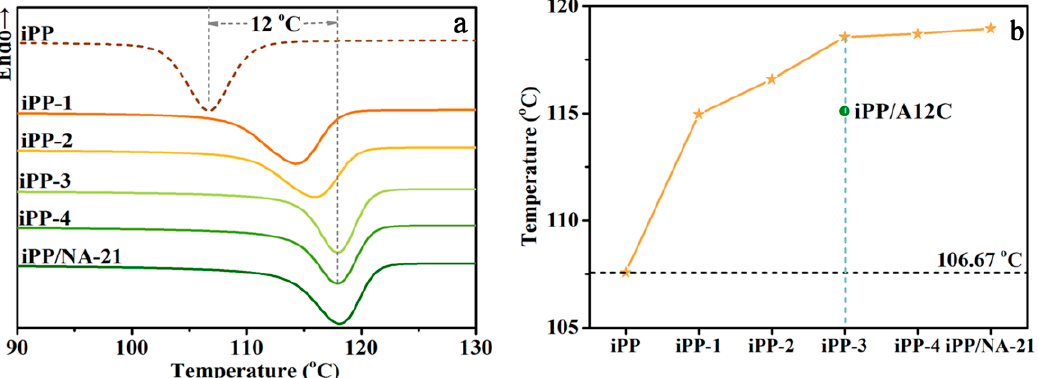
Figure 5. The non-isothermal crystallization curves ( a ) and the related T c,p ( b ) for the iPP/A12C-Li composites under a cooling rate of 10 °C/min.